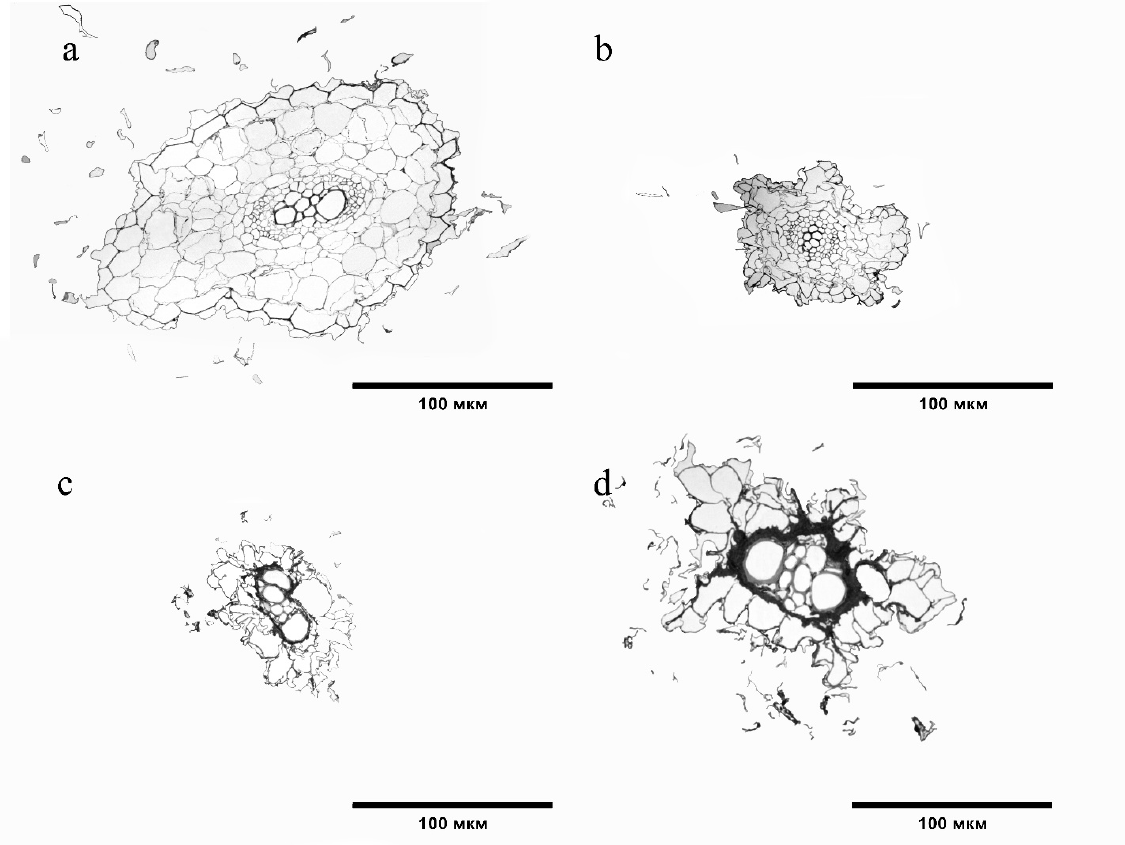
Figure 5. Cross sections of tomato roots: ( a ) Control; ( b ) 20 MPC BaP; ( c ) 40 MPC BaP; ( d ) 60 MPC BaP.